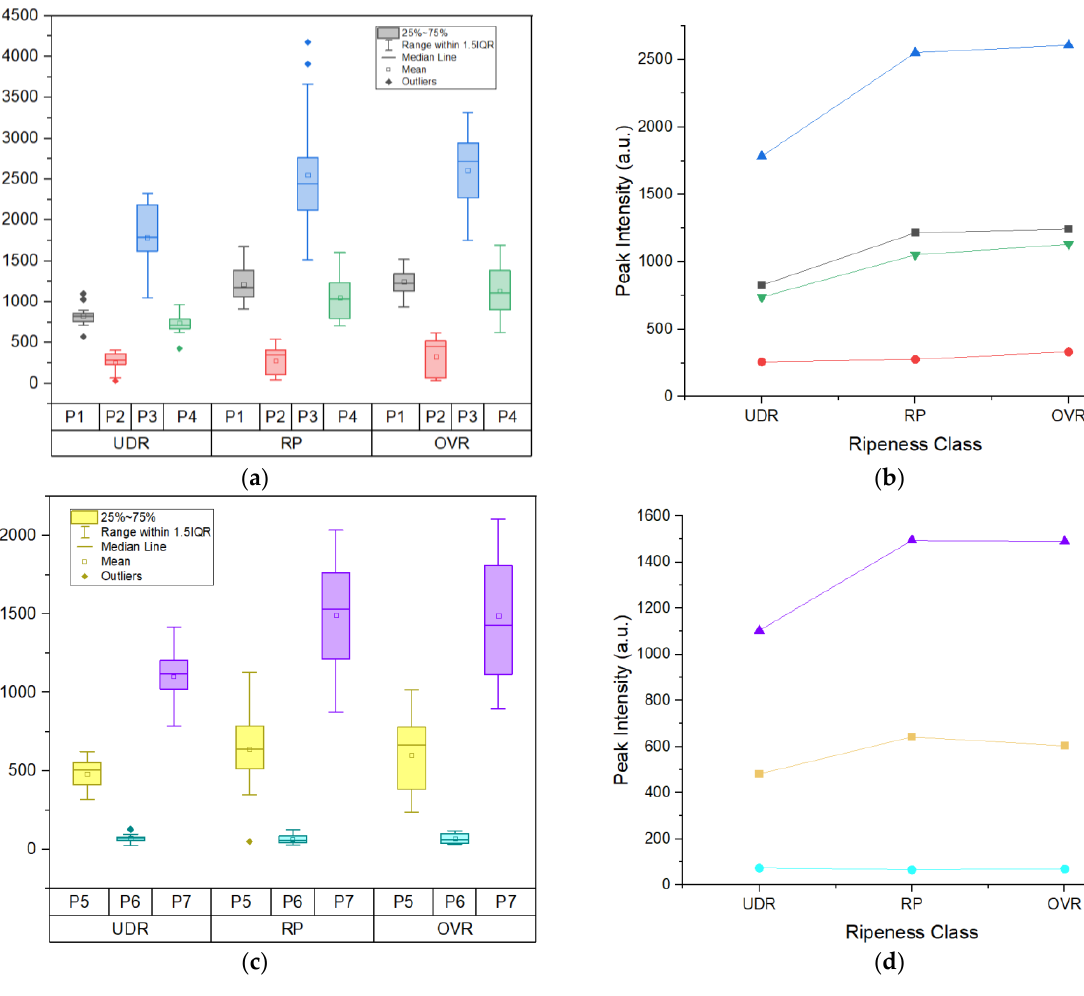
Figure 6. ( a ) Grouped box plot and ( b ) mean plot of peak’s intensity of 4 peaks in Area 1; ( c ) Grouped box plot and ( d ) mean plot of peak’s intensity of 3 peaks in Area 2. UDR: Under ripe, RP: Ripe, OVR: Over ripe; P1: β-carotene, P2: chlorophyll-a, P3: β-carotene, P4: amino acid, P5: β-carotene, P6: cu- ticular wax, P7: lycopene/β-carotene. Over ripe; P1: β -carotene, P2: chlorophyll-a, P3: β -carotene, P4: amino acid, P5: β -carotene,